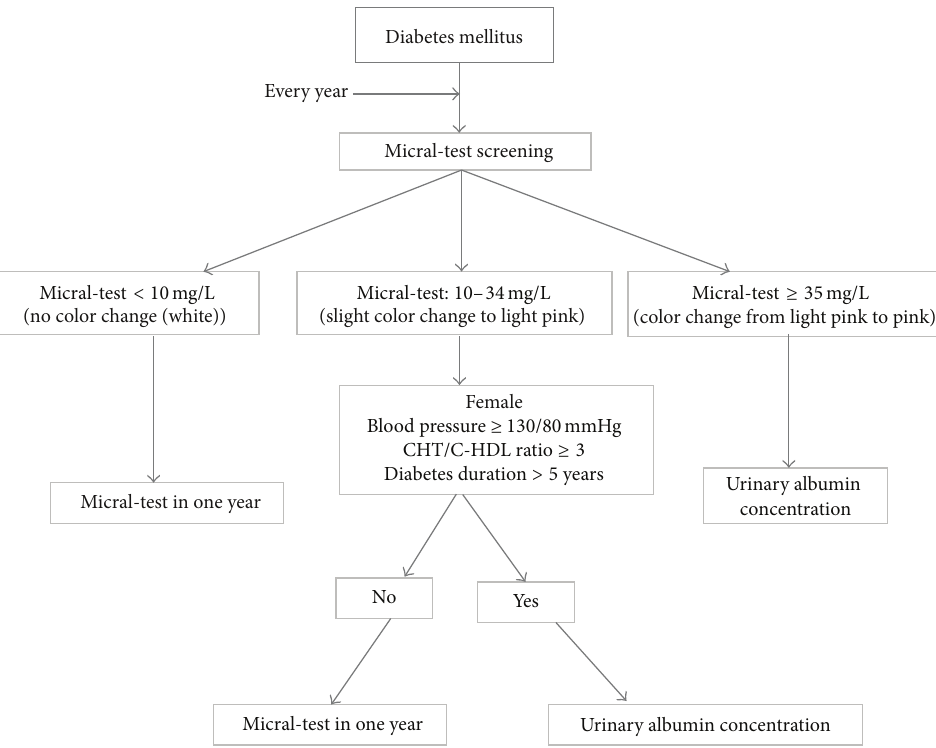
Figure 2: Algorithm for screening nephropathy in diabetes mellitus with Micral-test.